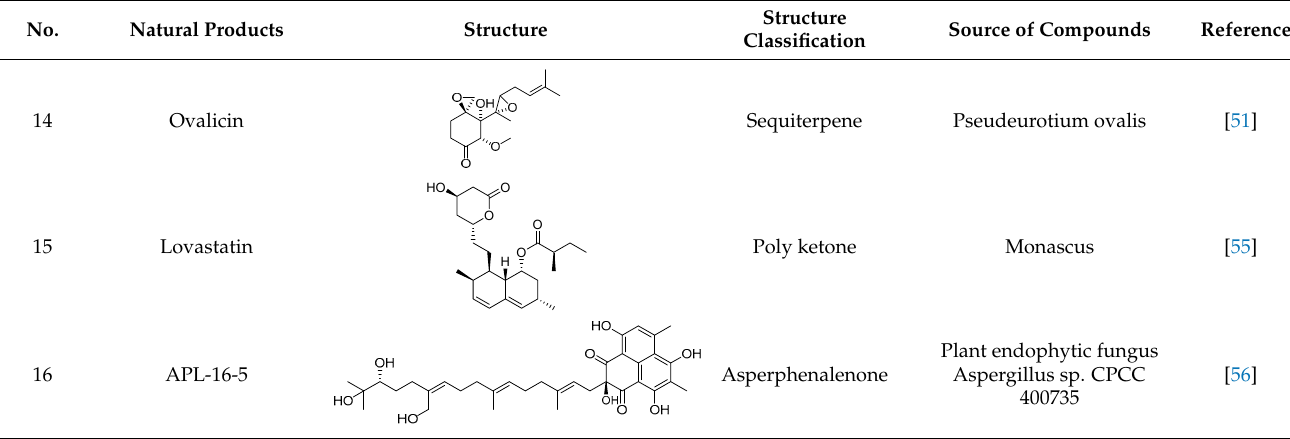
Table 7. Natural products 14–16.